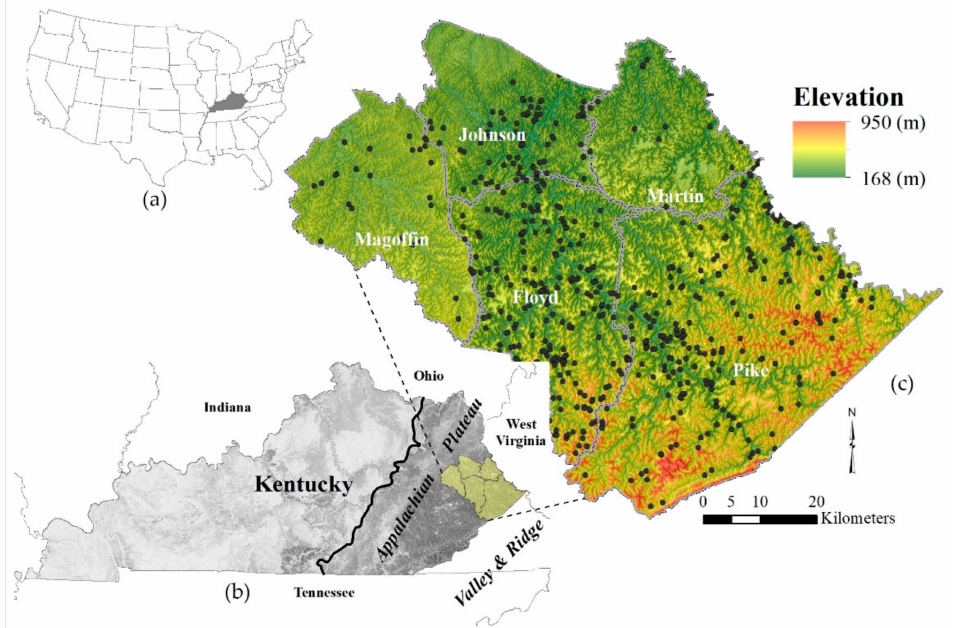
Figure 1. Map showing the locations of Kentucky, USA ( a ), the eastern Big Sandy Area Development District ( b ), and elevation map of the counties in the district ( c ). Black dots are documented landslides from the Kentucky Geological Survey inventory